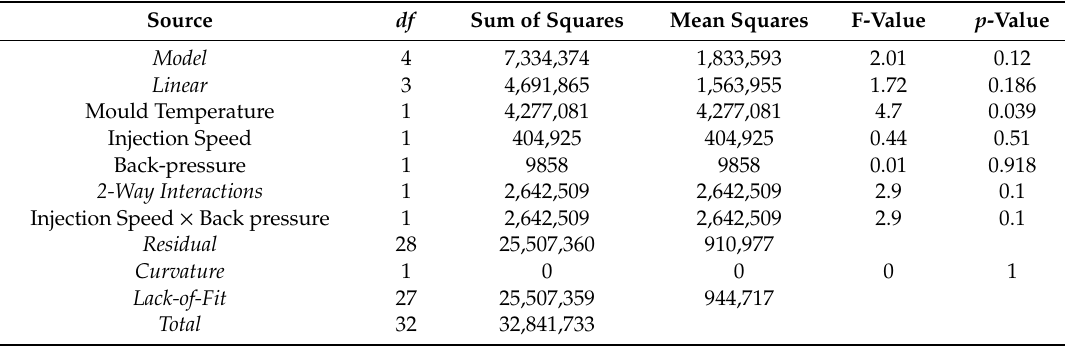
Figure 5. Main e ff ects plot for the R a results from the DoE. Figure 5. Main effects plot for the R a results from the DoE. Table 4. Analysis of variance linear model for R a against processing parameters.